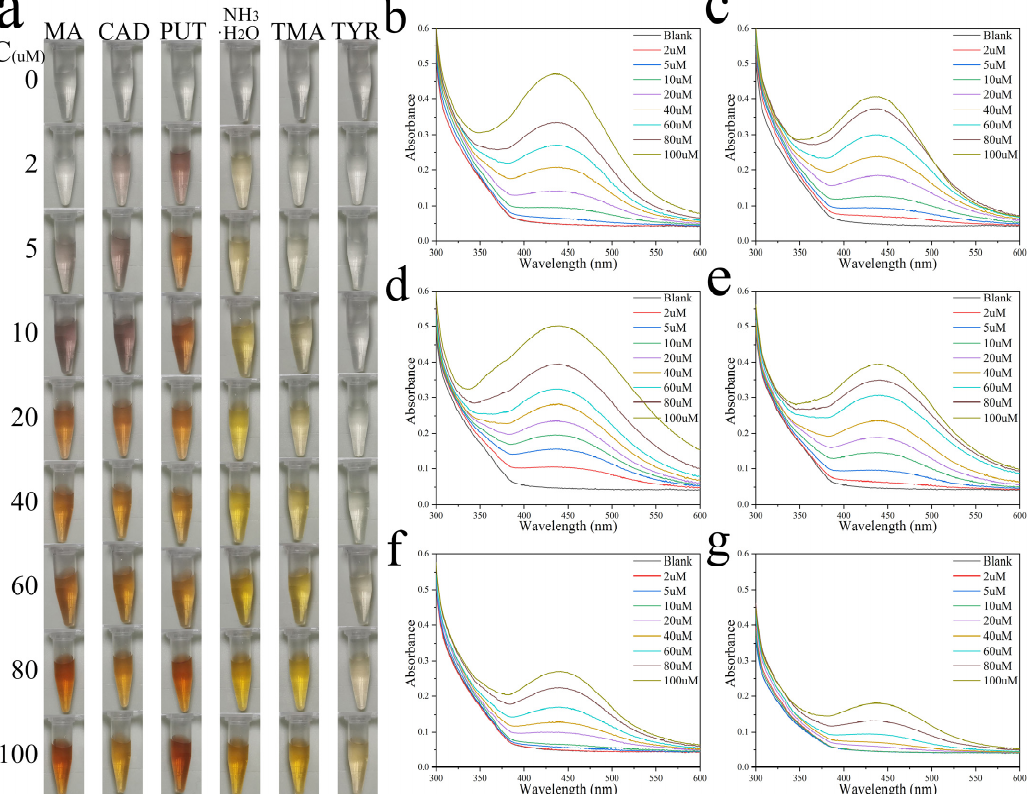
Figure 4. Discrimination among BAs with colorimetric Ag + probe. ( a ) Digital photographs of a colorimetric Ag + probe mixed with MA, CAD, PUT, NH 3 · H 2 O, TMA, and TYR solutions show different color combinations. The color of the colorimetric Ag + probe changed as the solution concentration was increased from 2 to 100 µM. ( b – g ) UV–vis spectra of colorimetric Ag + probe exposed to BAs solutions with different concentrations ( b ): MA, ( c ): CAD, ( d ): PUT, ( e ): NH3H2O, ( f ): TMA, ( g ): TYR).